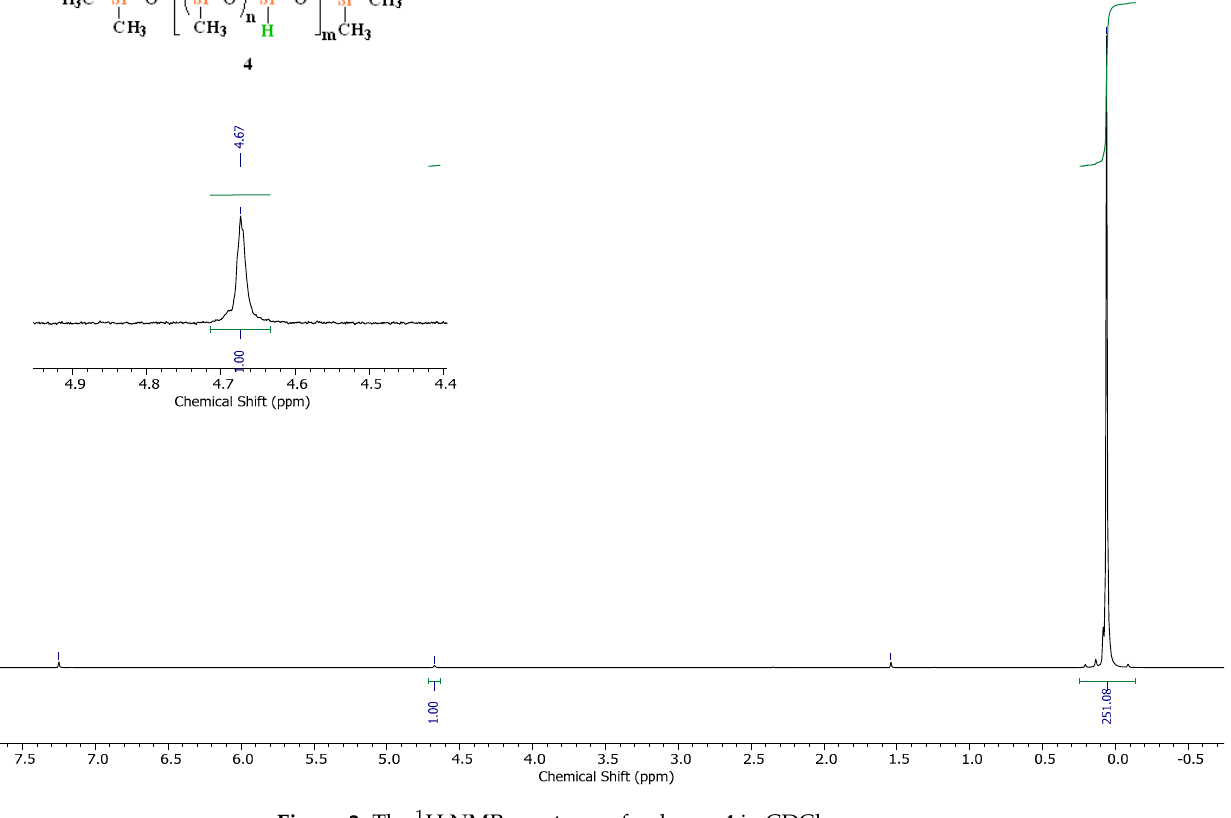
Figure 2. The 1 H NMR spectrum of polymer 4 in CDCl 3 .